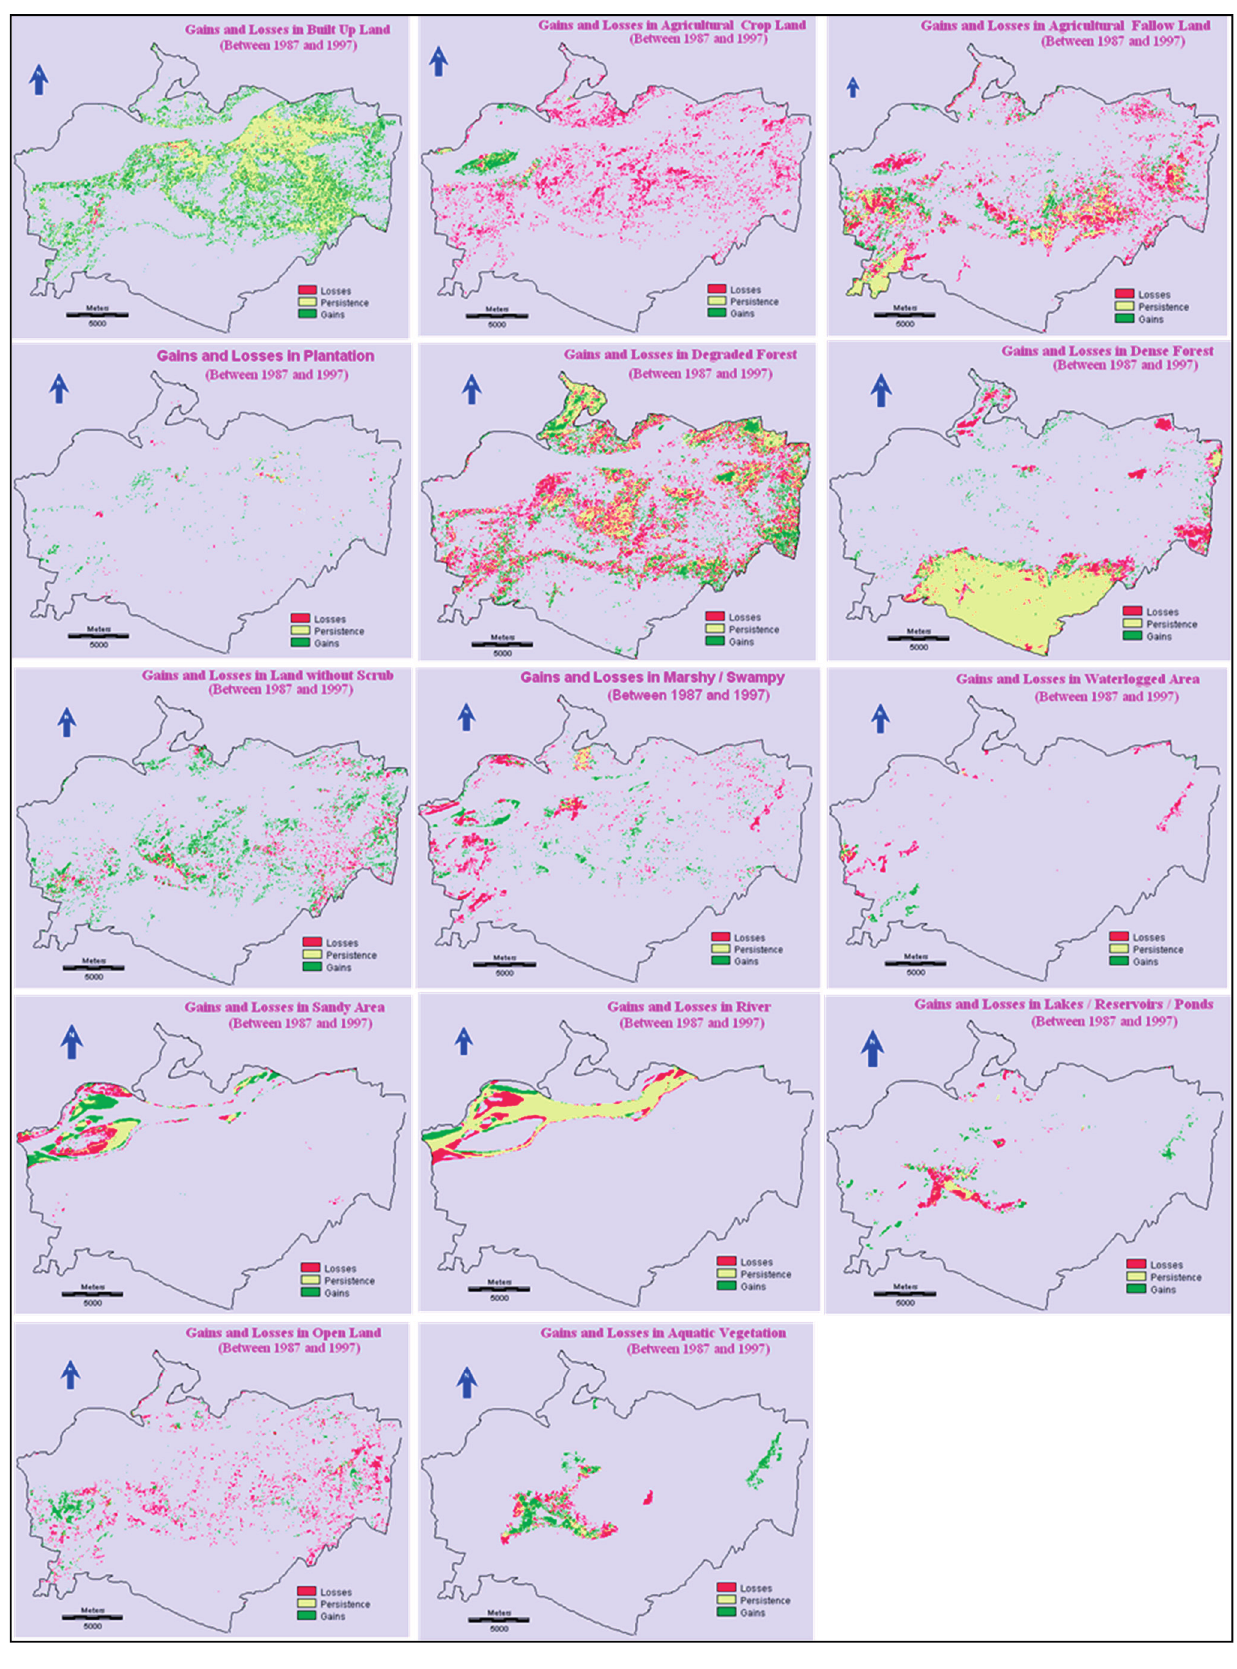
Figure 15. Gains, losses and persistence of each LULC category in time periods